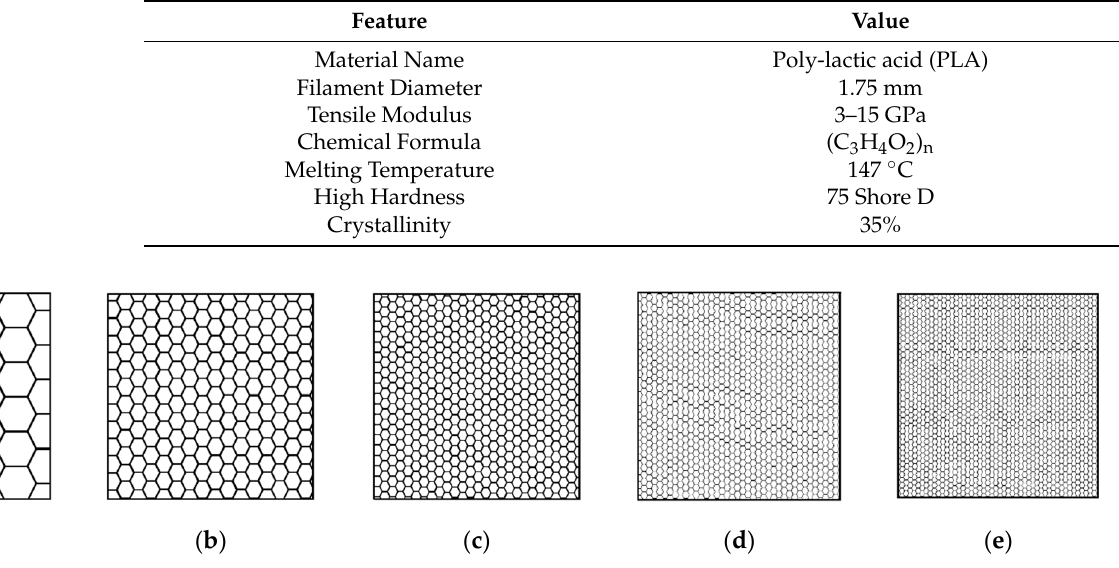
Figure 3. Shape of IP honeycomb: ( a ) 10%, ( b ) 20%, ( c ) 30%, ( d ) 40%, and ( e ) 50%. After assembling the samples, the specimens were evaluated for FL by a Santam STM-20 machine. Figure 4a shows that the clamp of the tensile device fixed the printed part, and Figure 4b depicts the samples after the tensile test.